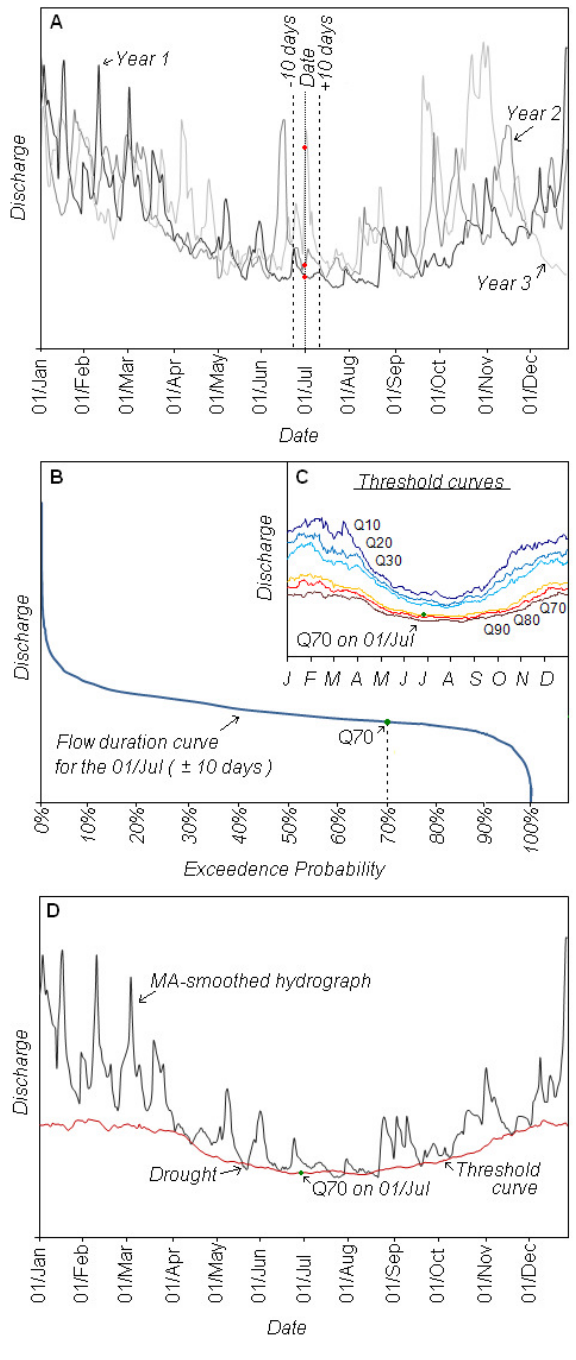
Fig. 3. Calculation steps from annual discharge series to a daily threshold curve. (A) Calculation of the threshold value for the 1 July with an enclosing time window of 21 days. (B) The flow duration curve of the 1 July, the green dot marks the 70th percentile. (C) The threshold curves for the whole year based on flow duration curve percentiles for each individual day. (D) The threshold curve for Q70 compared with the MA-pooled hydrograph for the